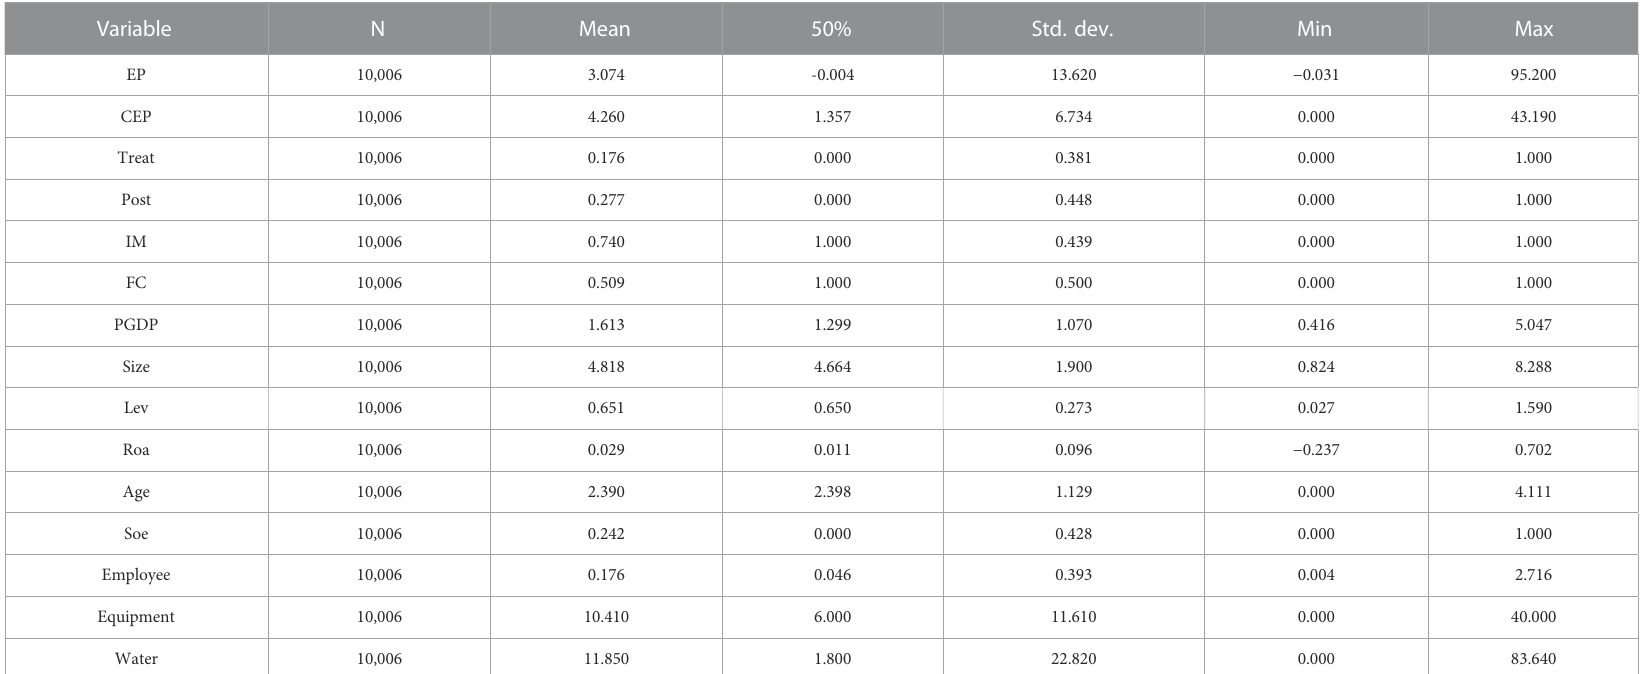
TABLE 2 Descriptive statistical